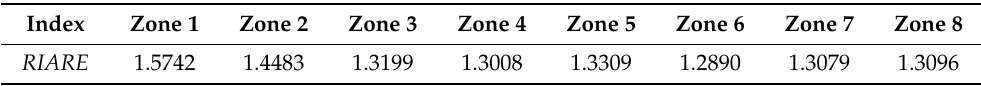
Table 5. Indices for RIARE in the reference tracking experiment based on multiple lighting